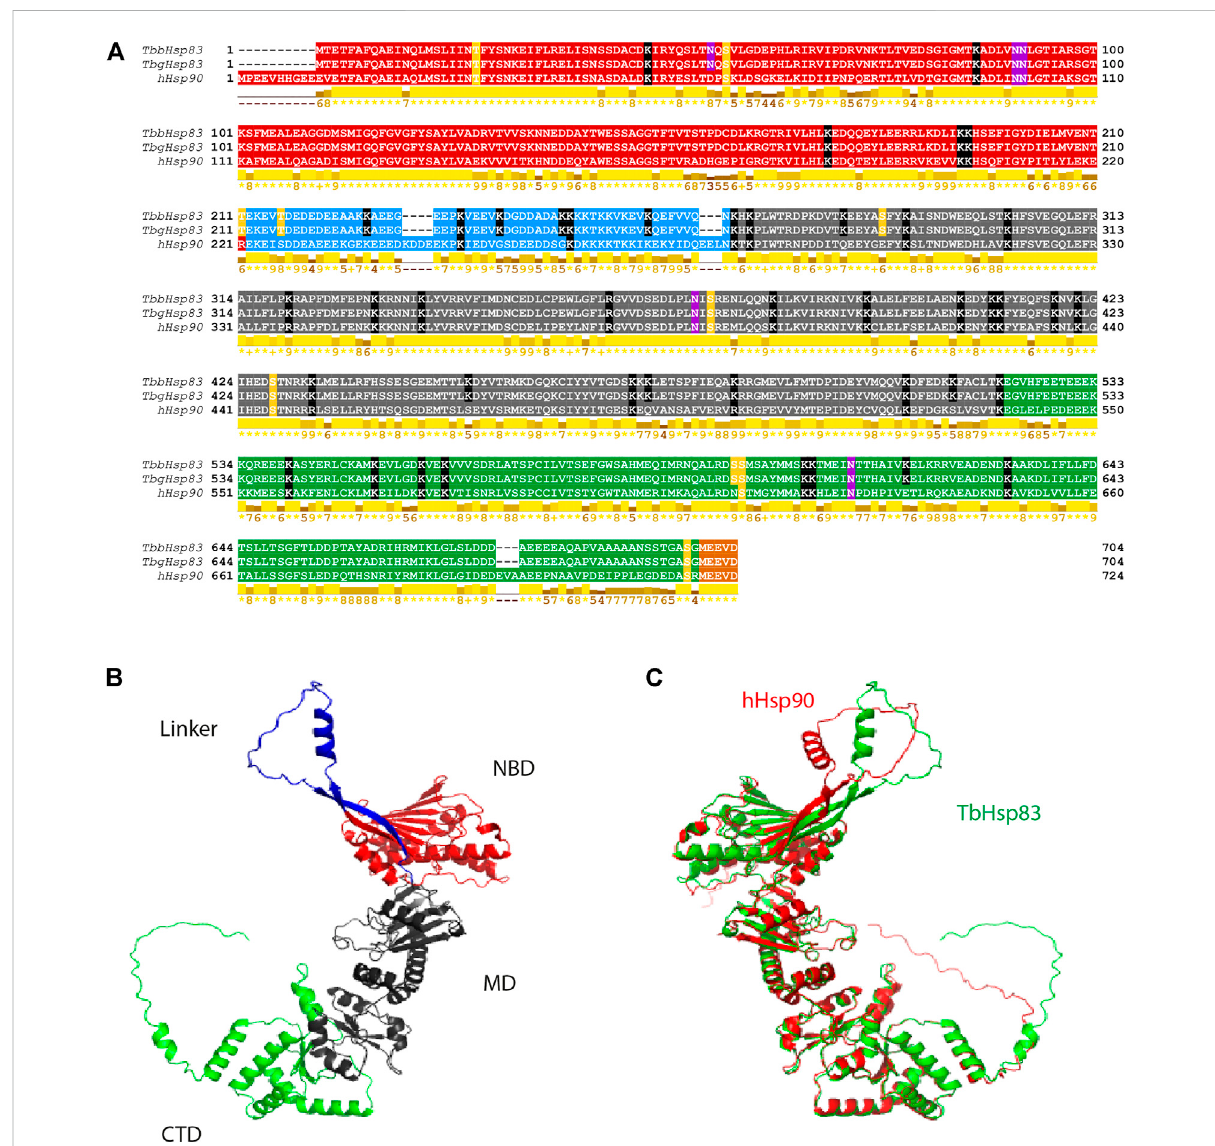
FIGURE 2 Sequence alignment and 3D structural analysis of TbHSP90. (A) Multiple sequence alignment of hHSP90, TbbHSP83, and TbgHSP83. The NTD is highlighted in red, the charged linker domain in blue, the MD in gray, the CTD in green, and the MEEVD motif in orange. The PTMs are highlighted: yellow – phosphorylation, black — acetylation, and pink — N-glycosylation. Conserved residues involved in ATP interaction are highlighted in brown. Conservation based on physico-chemical properties is shown as a numerical index at the bottom of the alignment: “ * ” denotes score of 11 where amino acid residues are identical; “ + ” denotes score of 10 and indicates all properties are conserved. (B) Predicted 3D structure of the TbHSP83 monomer and (C) superimposed 3D structures of TbHSP83 (green) and hHSP90